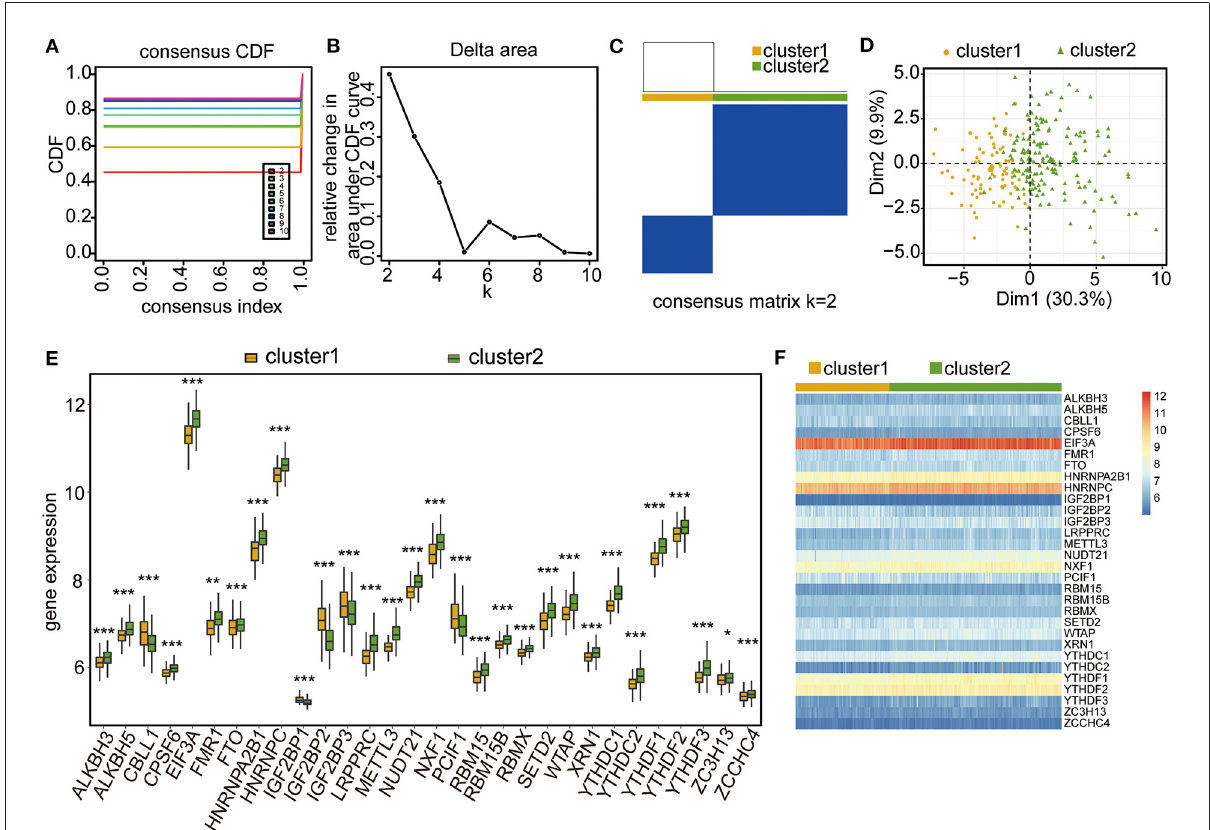
FIGURE4 Unsupervised clustering analysis of CHD samples based on the four-gene significance. (A–C) Unsupervised clustering result of CHD samples. (D) PCA analysis of the two m6A RNA modification patterns. (E) Box plot showing the expressional levels of the 30 m6A regulators in the two m6A RNA modification patterns. The statistical significance was calculated via Wilcoxon rank sum test, *** P < 0.001, ** P < 0.01, * P < 0.05. (F) Heatmap showing the expressional levels of the 30 m6A regulators in the two m6A RNA modification